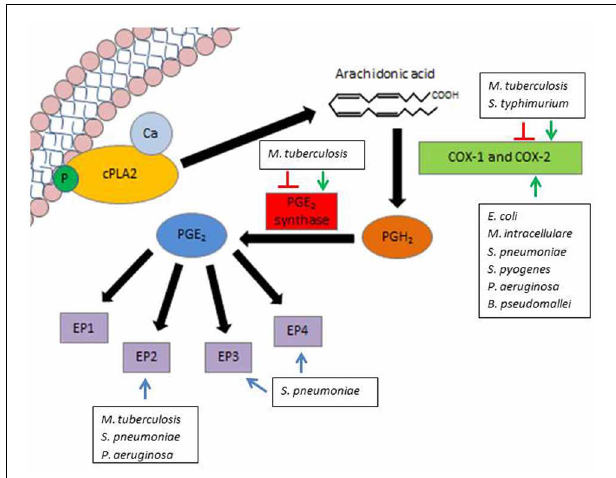
FIGURE 1 | Modulation of PGE 2 by pathogenic bacteria. PGE 2 synthesis is initiated by the release of AA from the lipid cell membrane by the enzyme cPLA2. Either COX-1 (constitutively expressed) or COX-2 (inducible) can utilize AA as a substrate to produce the precursor PGH 2 . PGH 2 is converted to biologically active PGE 2 by means of the enzyme PGE 2 synthase. PGE 2 can then readily signal through one of four EP, denoted EP1, EP2, EP3, and EP4. Various pathogens influence PGE 2 production and signaling along different steps of this pathway. Green arrows indicate activation of COX-2 or PGES, while red lines indicate inhibition of COX-2 or PGES by select pathogens. Blue lines indicate a potential role for EP signaling in pathogen